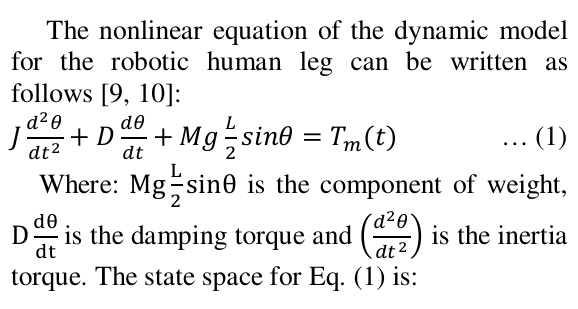
The nonlinear equation of the dynamic